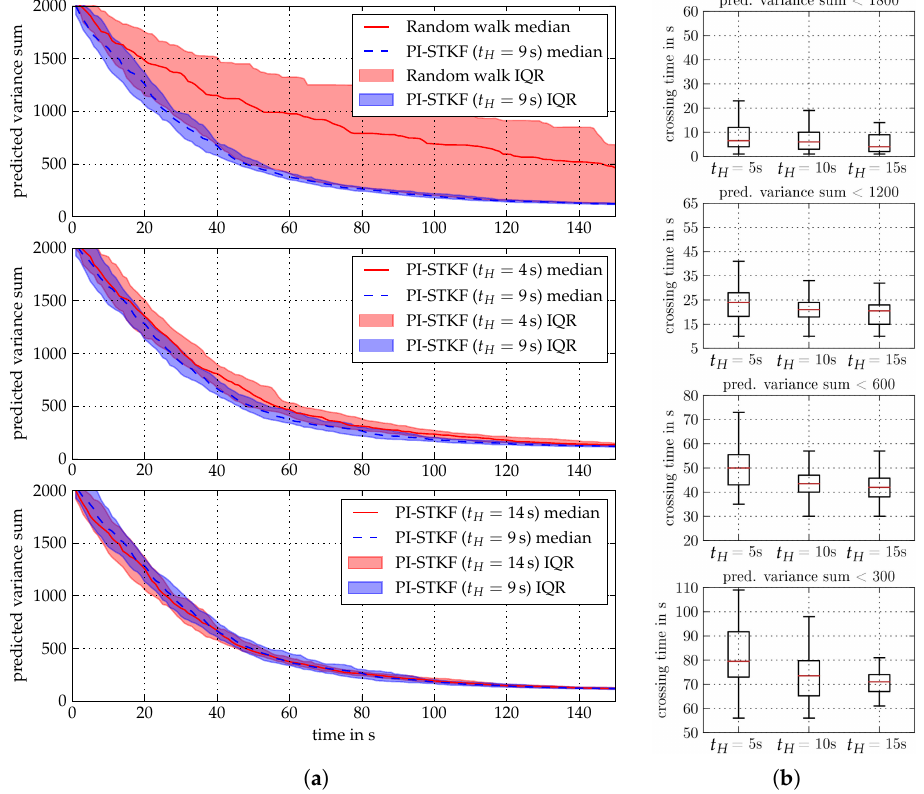
Figure 14. ( a ) Median and IQR of the conditional variance sum of the PI-STKF and a random walk exploration strategy after 50 simulation runs. ( b ) Box plot of the crossing times of a particular conditional variance sum for different control horizons t H over 50 simulation